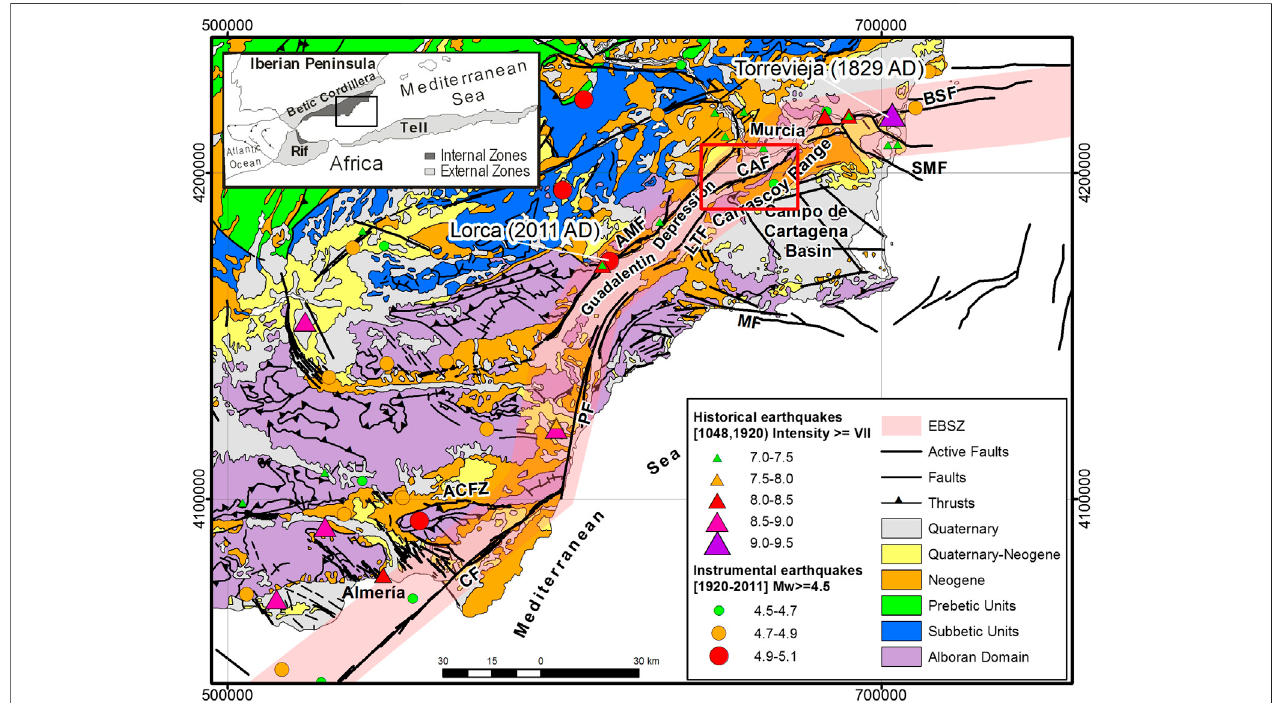
FIGURE1| GeologicalsettingoftheCarrascoyFault.EBSZ:EasternBeticShearZone;SMF:SanMigueldeSalinasFault;BSF:BajoSeguraFault;CAF:Carrascoy Fault; LTF: Los Tollos Fault; AMF: Alhama de Murcia Fault; PF: Palomares Fault; CF. Carboneras Fault; ACFZ: Alpujarrides Corridor Fault Zone; MF: Las Moreras - EscarpedeMazarrónFault.GeologicalmappingcarriedoutfromContinuousDigitalGeologicalMapatscale1:50.000oftheInternalZonesoftheBeticCordillera(Marín- Lechadoetal.,2011).FaulttracesarefromanupdatedversionofQAFIdatabase(García-Mayordomoetal.,2012;IGME,2012).Earthquakedatacorrespondstoa declustered version of the Spanish national seismic catalog (IGN-UPM, 2013). The white lines show the identi fi cation of major earthquakes cited in the text. Location of the Carrascoy Fault and Figure 2A (red square).